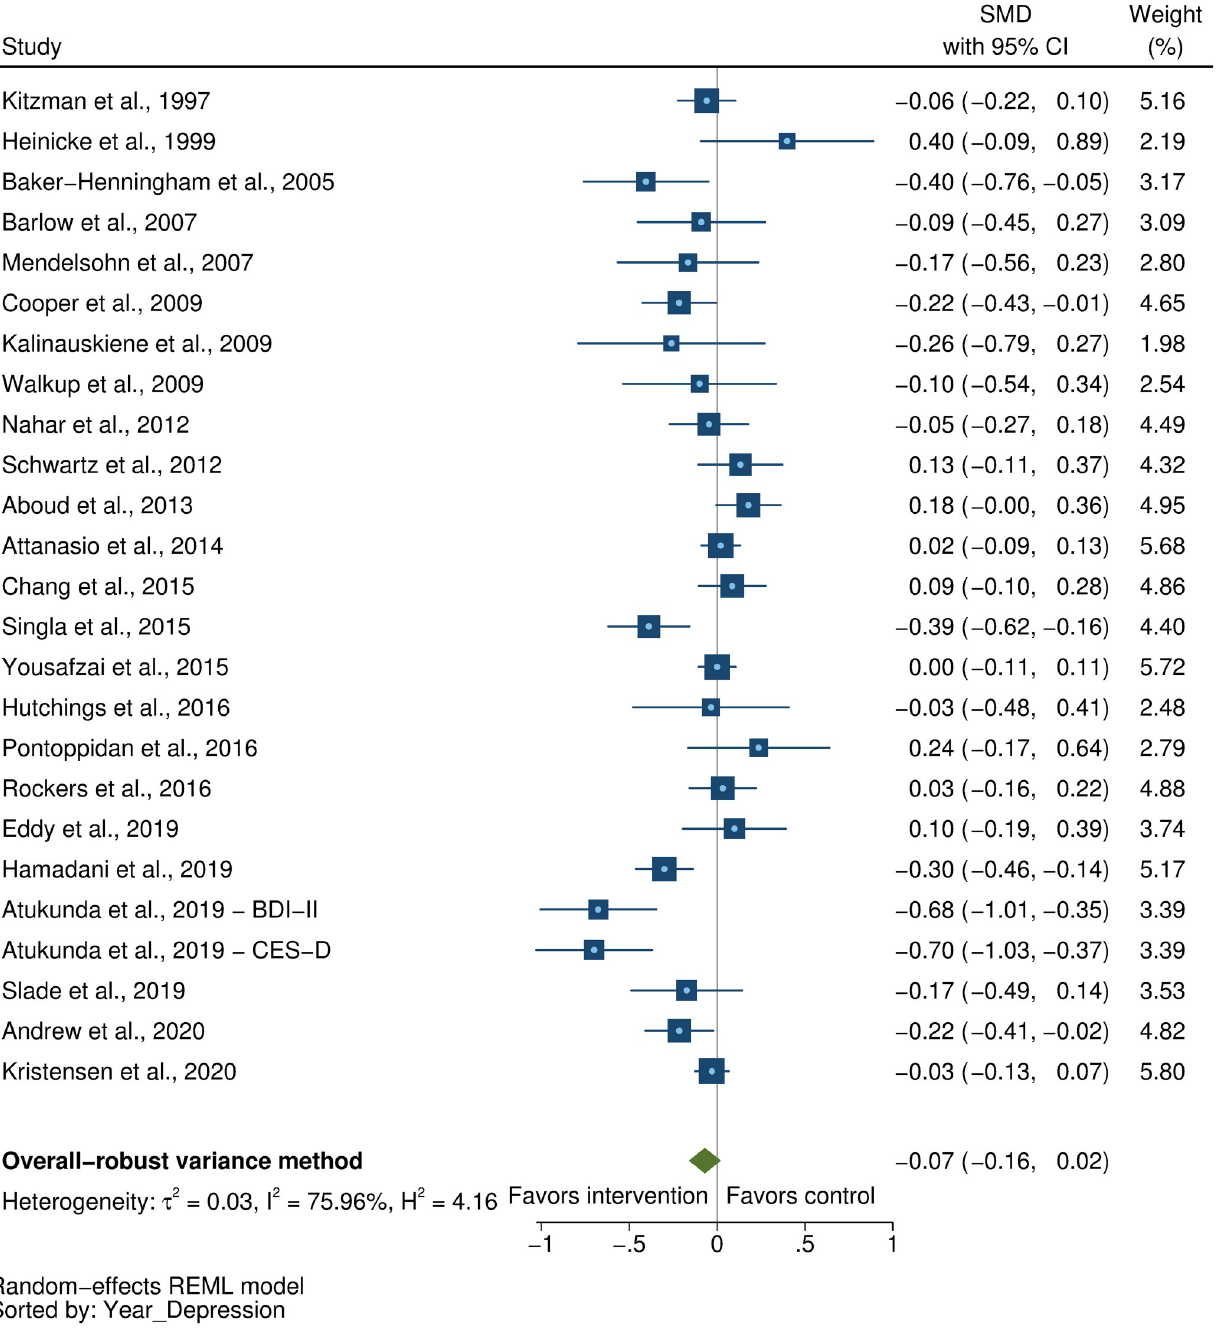
Fig 11. Forest plot for the effect of parenting interventions on parental depressive symptoms. Blue squares represent the SMD for each study, with the size of the square being proportional to the study weight. The whiskers extending from each side of the square represent the range of the 95% CI. The green diamond shows the overall pooled effect size using a random-effects model, which is centered at the point estimate and the diamond width representing the 95% CI. SMD, standardized mean difference.